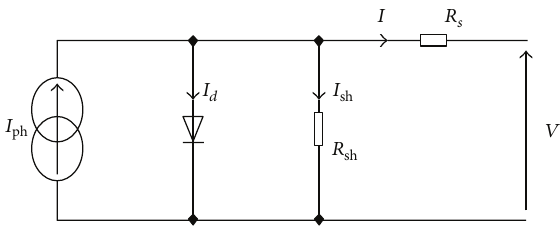
Figure 1: Equivalent electrical circuit for the one-diode